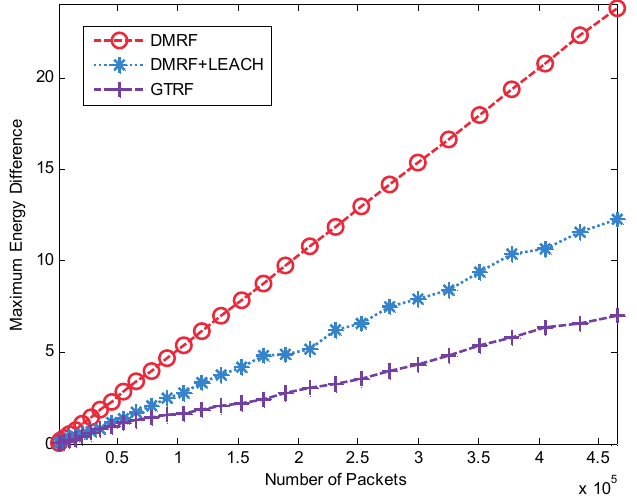
Figure 8. Energy difference between maximum and minimum energy node with selfish nodes.